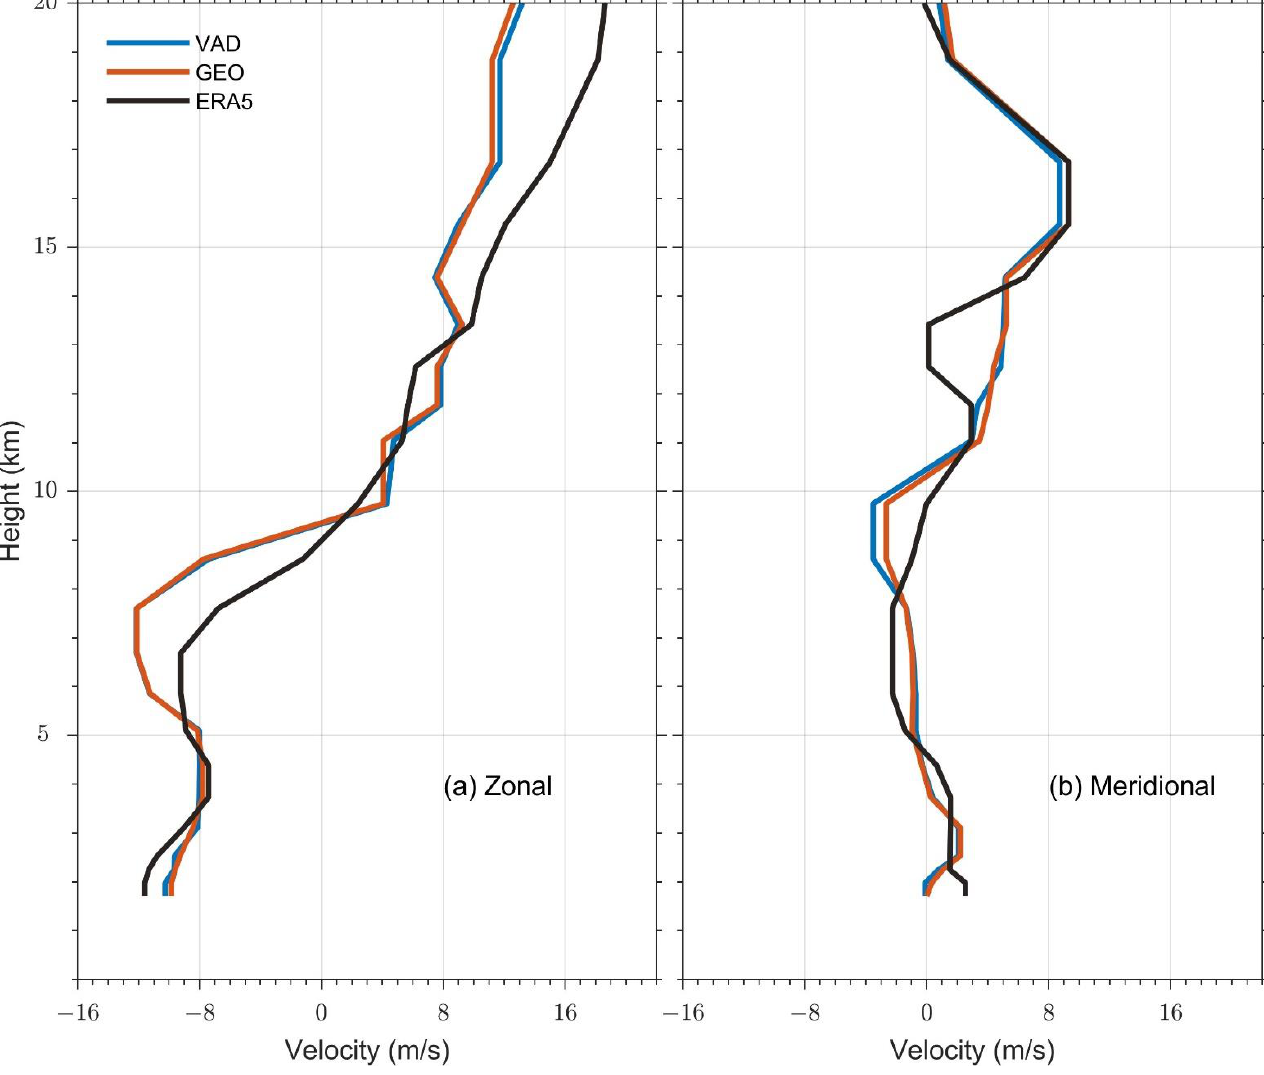
Figure 7. Height distributions of zonal wind ( a ) and meridional wind ( b ) derived from the VAD and GEO methods for zenith angles 6°, and the reanalysis ERA5 data (distinguished by colors) from 15:00 on 21 July 2021, in experiment #3.